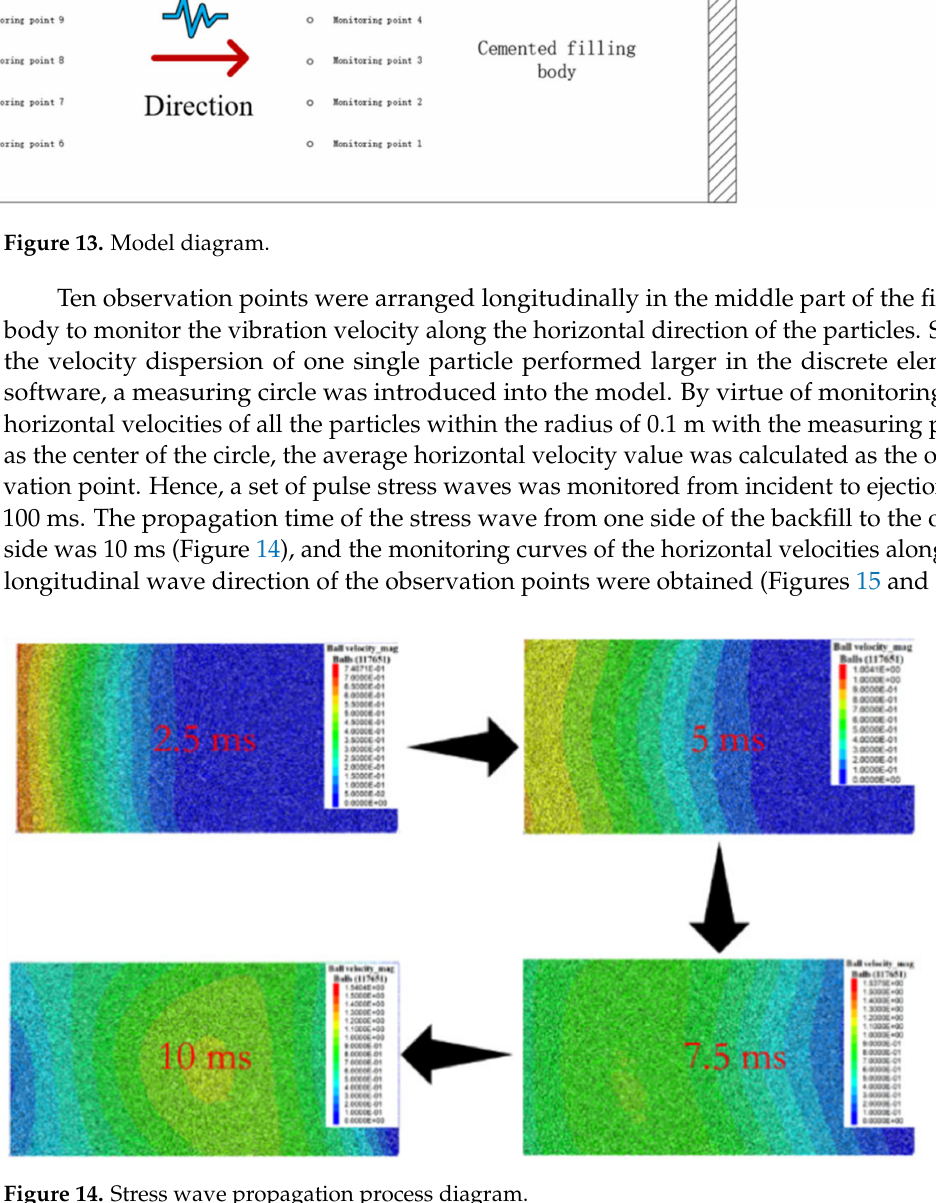
Figure 14. Stress wave propagation process